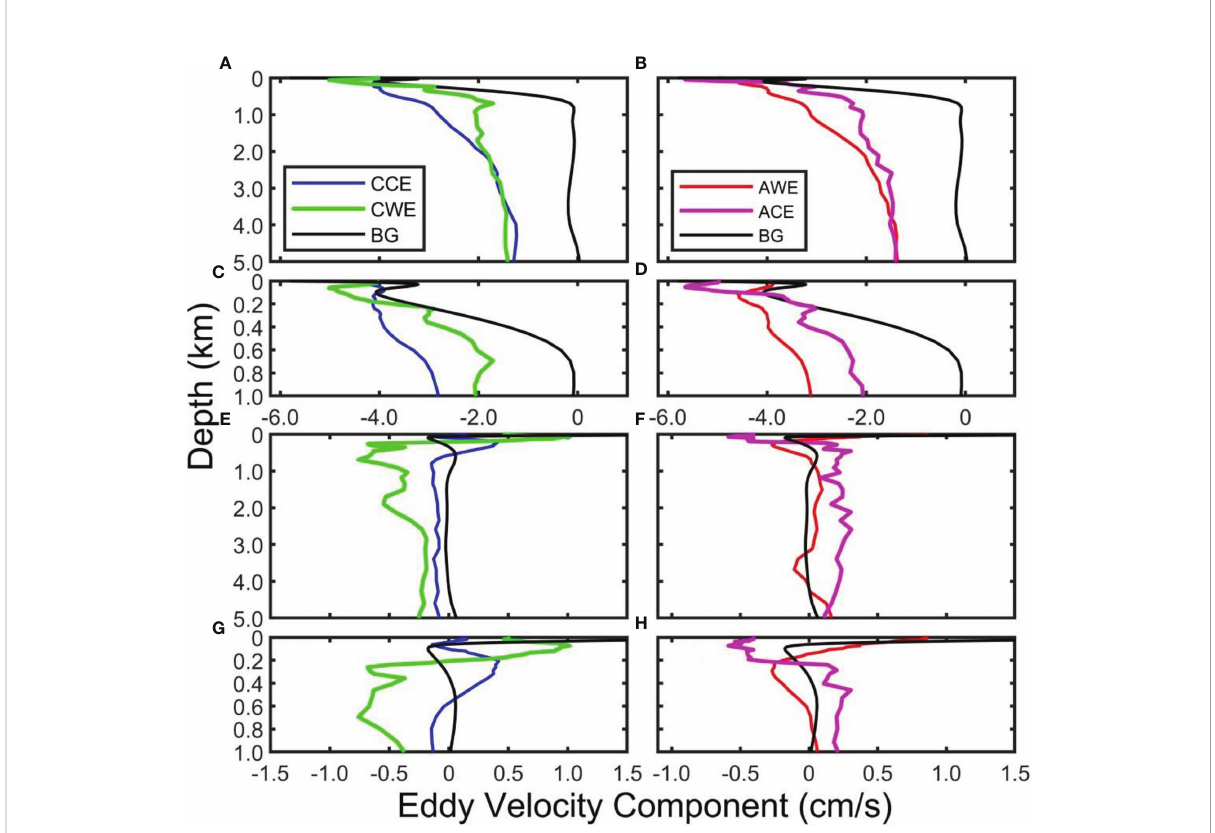
FIGURE 12 Vertical distribution of eddy zonal (A – D) and meridional (E – H) velocity component (units: cm/s). Blue, red, green, magenta, and black curves represent the eddy velocity component of cyclonic cold-core eddy, anticyclonic warm-core eddy, cyclonic warm-core eddy, anticyclonic cold- core eddy and multi-year average background fi eld,